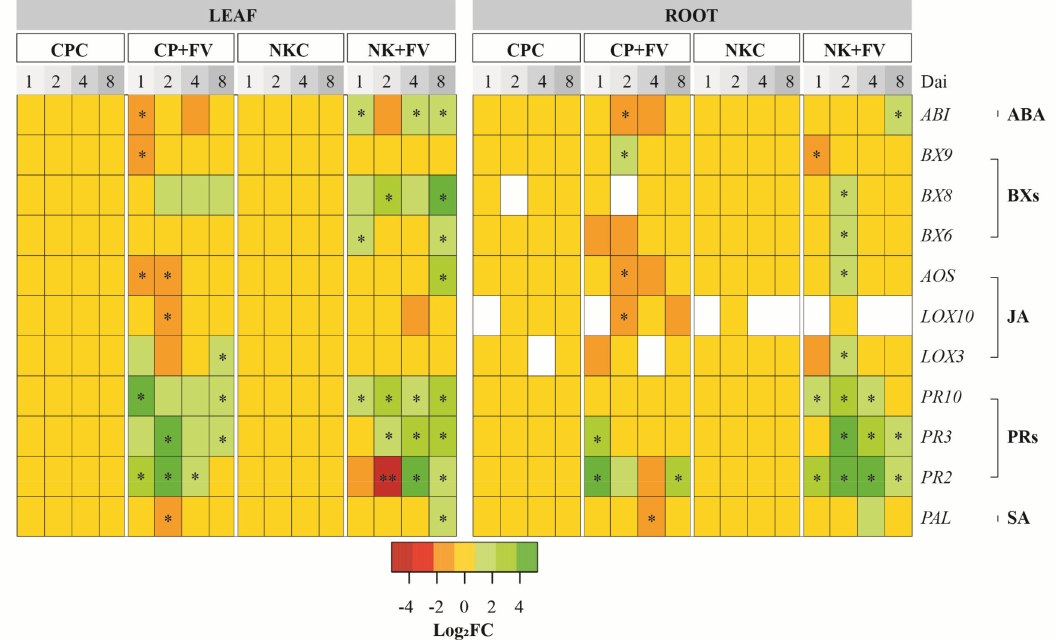
Figure 3. Heat map of the differential gene expression levels in leaf and root of two hybrid maize lines, CP888 and Bt/GT NK7328. The colors indicate the fold changes (FC) of gene expression in log base 2. Up-regulation of each gene is shown in green (increased abundance), down-regulation is shown in red (decreased abundance), no change is shown in yellow, and no expression is indicated in white. Fusarium verticillioides (FV); salicylic acid (SA); jasmonic acid (JA); benzoxazinoids (BXs); abscisic acid (ABA). Dai = days after inoculation. Defense response was monitored at 1, 2, 4 and 8 dai. Control CP888- or NK7328 plants mock-infected with sterile water (CPC and NKC, respectively). CP888- or NK7328 plants infected with F. verticillioides strain F01.12 (CP+FV and NK+FV, respectively). Symbols (*) and (**) depict significant difference at significance levels of α = 0.05 and α = 0.01, respectively, between the infected and the control mock plants within a cultivar using one-tailed Kruskal-Wallis